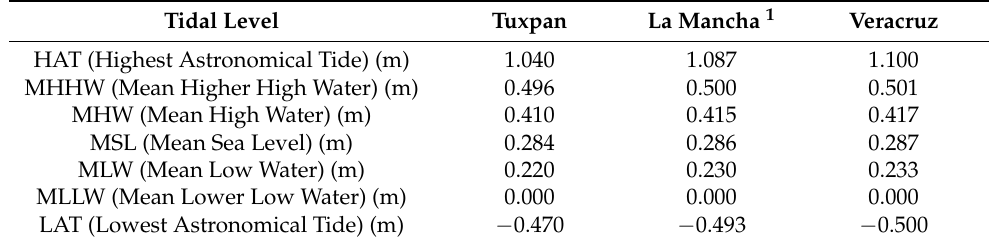
Table 1. Tidal levels referring to the MLLW (mean lower low water), data from SEMAR [28,29]. Tidal